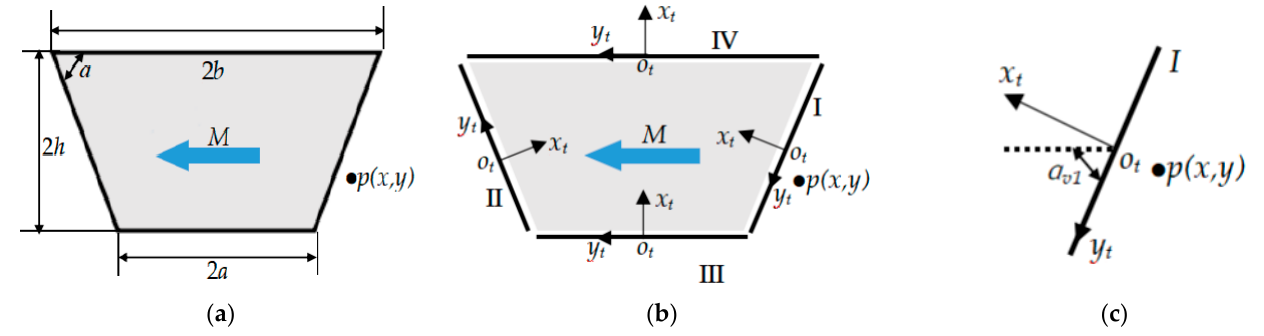
Figure 2. Schematic diagram of improved equivalent analytic algorithm modeling with trapezoidal side length as a unit: ( a ) horizontal left magnetization, ( b ) relative coordinate system established by side length, and ( c ) angle α v 1 between side I and the magnetizing direction.